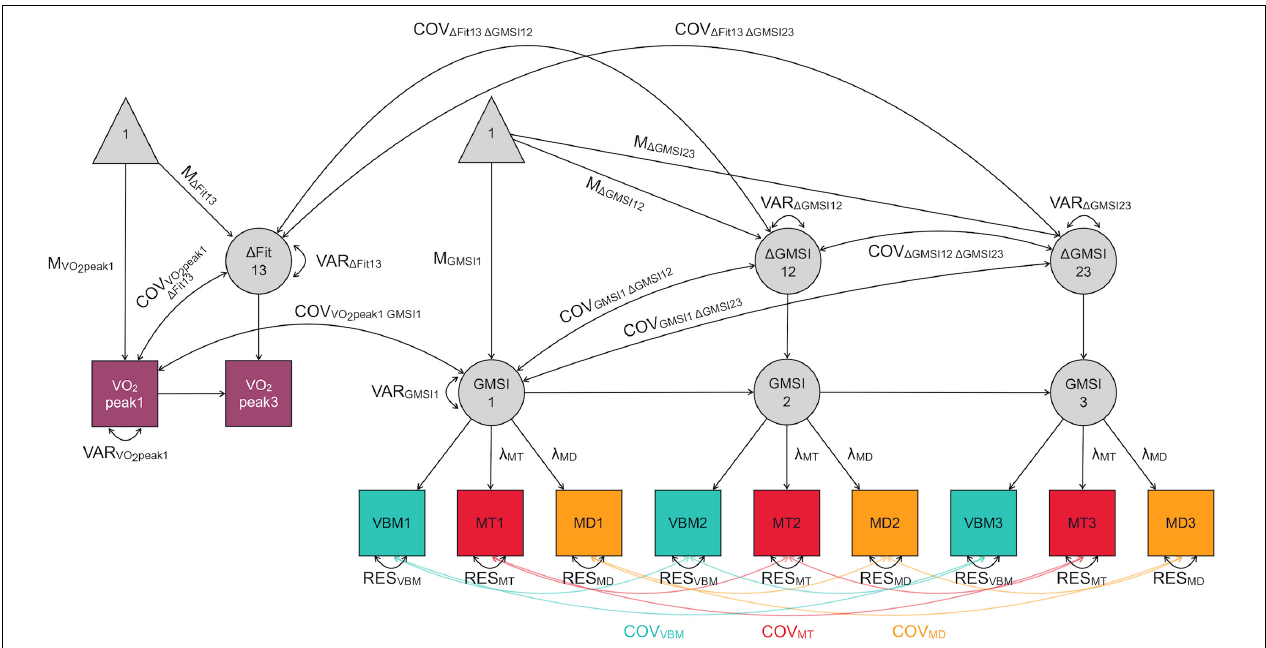
FIGURE 1 | Exemplary bivariate latent change score model measuring the covariance between change in cardiovascular fitness from T1 to T3 and change in gray-matter structural integrity in a given region of interest from T1 to T2 and T2 to T3. Fit, cardiovascular fitness; GMSI, gray-matter structural integrity; VBM, voxel-based morphometry-derived gray-matter probability; MD, mean diffusivity; MT, magnetization transfer saturation; 1, time point 1 (T1; 0 months); 2, time point 2 (T2; 3 months); 3, time point 3 (T3; 6 months); (cid:49) , change; M, mean; COV, covariance; VAR, variance; λ , loading; RES, residual. Covariances between manifest variables of integrity were set to be equal within each modality, denoted by color-coding; these are only labeled once for visual clarity. Other unlabeled paths are fixed to 1.